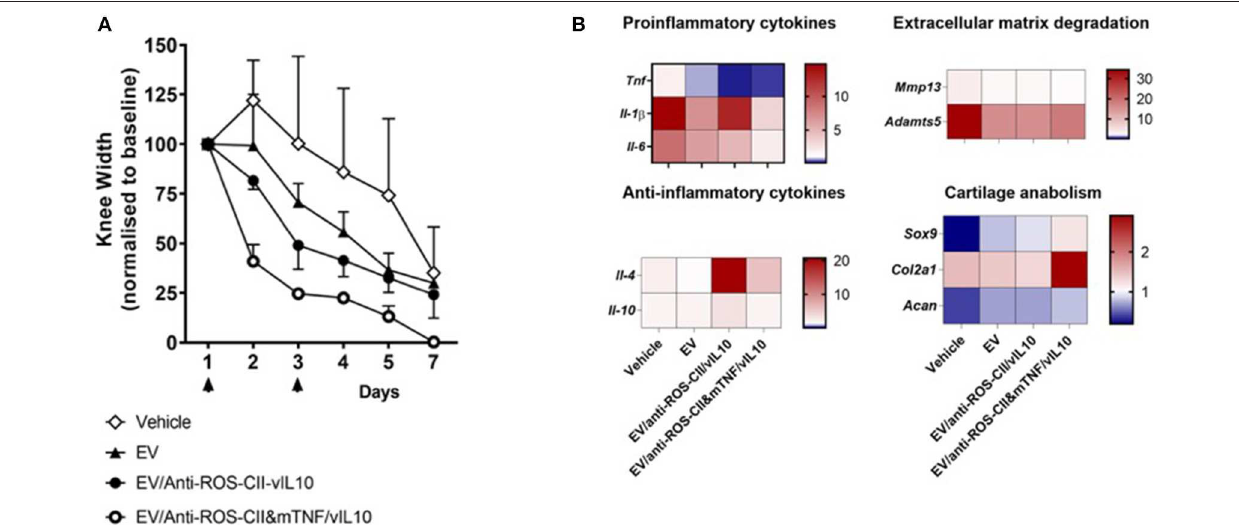
FIGURE 5 | Treatment of antigen-induced arthritis with EV fortified with combined treatment. Antigen-induced arthritis was induced in the right knee of female C57BL/6 mice. On day 1 and 3, mice were injected with 6 × 10 5 i.v. of EV alone, EV/anti-ROS-CII-vIL-10, EV/anti-ROS-CII&mTNF/vIL-10, or vehicle. (A) Knee swelling was monitored using digital calipers. Data are expressed as mean ± SEM, n = 5 mice per treatment group ( n = 3 mice for the vehicle group). Data were analyzed using a mixed-model ANOVA, allowing for a random intercept and slope of day (which was entered as a continuous variable), with treatment as a fixed factor. There were significant main effects of treatment and day, and Holm–Sidak post-hoc tests comparing the overall knee width of each treatment group to the vehicle group indicated lower knee widths for EV/anti-ROS-CII-vIL-10 ( p = 0.0499) and EV/anti-ROS-CII-vIL-10/anti-TNF ( p = 0.001) treatment groups (control groups are the same as in Figure 4A , bottom panel). There were no significant differences between the vehicle group and the EV alone ( p = 0.216). (B) Local gene expression was measured by quantitative PCR (qPCR) in the arthritic joints at day 7. Data were normalized over the RPL32 housekeeping gene and are expressed as fold change over control knee joints from naive mice, with average expression levels represented using a heat map ( n = 3 mice per